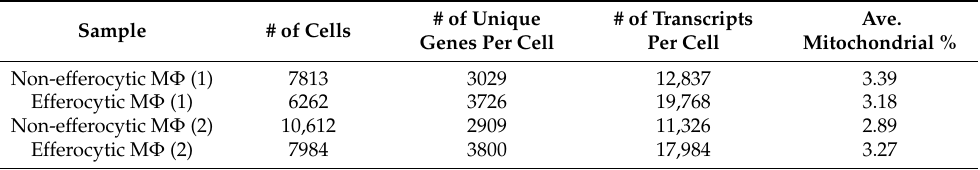
Table A1. Features of the data included in the single-cell RNA sequencing analysis.